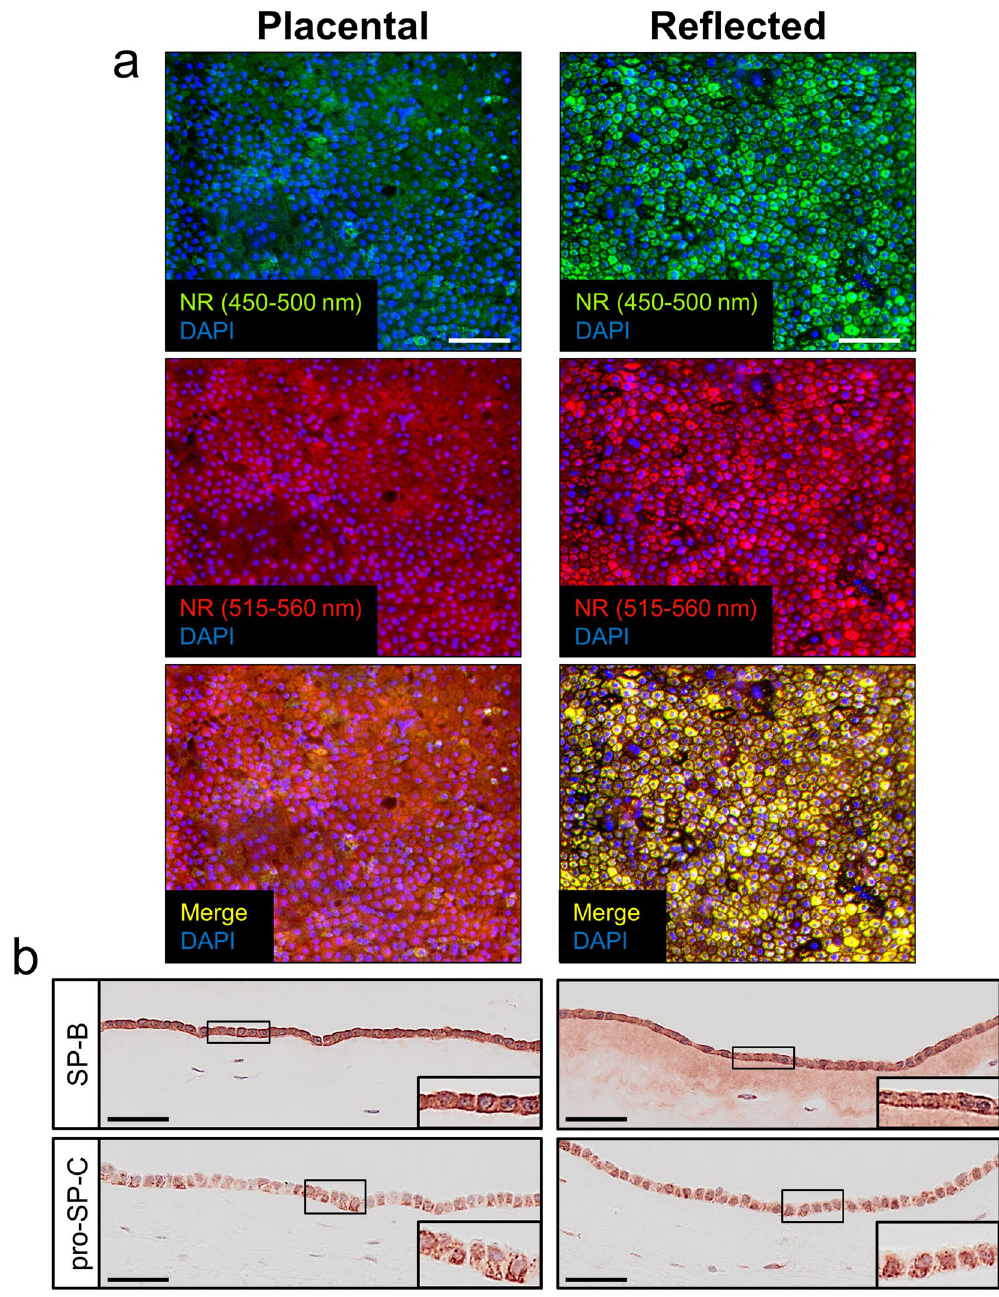
Figure 2. hAM explants show distinct expression of PS-associated components. ( a ) Visualization of intracellular (phospho-)lipid vesicles with NR staining. Explants of placental hAM display moderate numbers of neutral (upper row, green) and phospholipid vesicles (middle row, red), whereas cells of reflected hAM contain a considerable amount of both lipid classes covering the whole amniotic epithelium. n = 6. Upper row: neutral lipid vesicles (green, 450–500 nm excitation); middle row: phospholipid vesicles (red, 515–560 nm excitation); lower row: merge; counterstaining was performed with DAPI (blue). Scale bars: 50 µ m. NR = Nile red. ( b ) Representative anti-SP-B and anti-pro-SP-C staining of hAM explants immediately after isolation. Placental- associated hAM shows strong SP-B expression (n = 4) in epithelial cells and fainter staining in mesenchymal cells, whereas in the reflected region of hAM even extracellular matrix exhibits specific SP-B staining. Pro-SP-C (n = 5) is similarly distributed in cells of both amniotic subregions. Scale bars: 50 µ